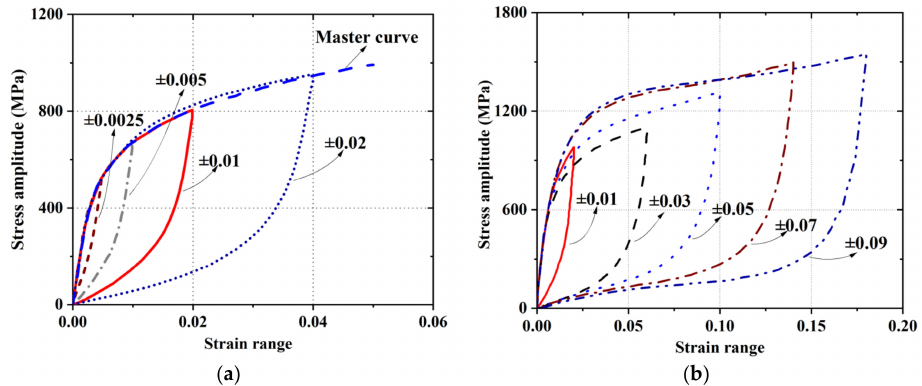
Figure 9. Adaptability of Fe-SMA to Masing behavior under ( a ) small strain ranges [84]; and ( b ) large strain ranges